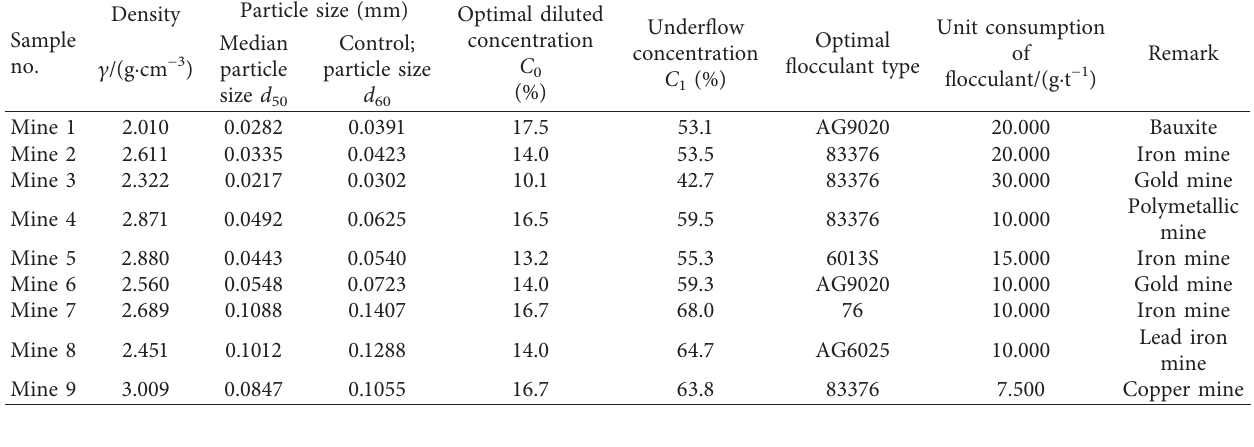
Table 1: Summary of static flocculation settlement test results of various mines.